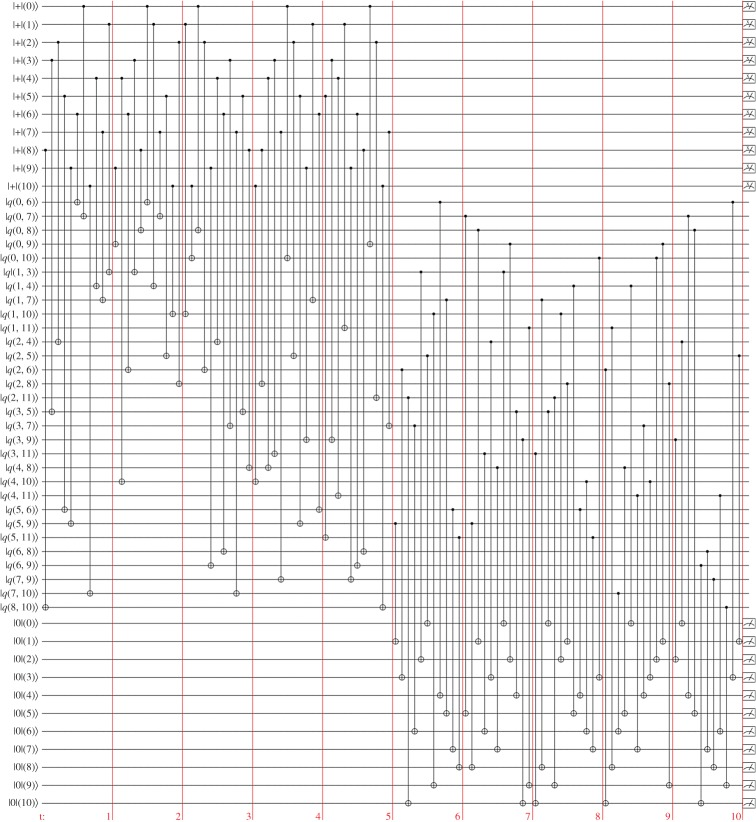
The parity check circuit for one EC round for the small stellated dodecahedron code involving 11 ancilla qubits starting in |+〉 for the X-check measurement and 11 ancilla qubits in |0〉 for the Z-check measurement. The parity check measurements are accomplished in 10 rounds (separated by red vertical lines), corresponding to a graph colouring with 10 colours.